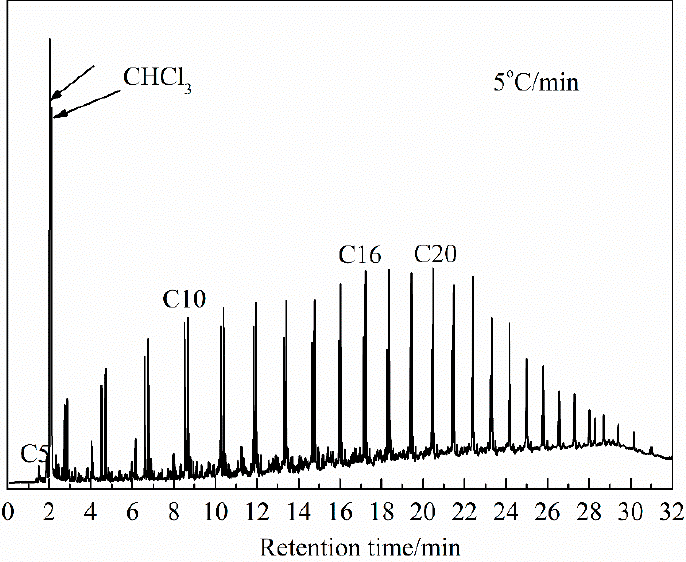
Figure 7. Ion-flow chromatogram of shale oil, derived at a heating rate of 5°C/min.